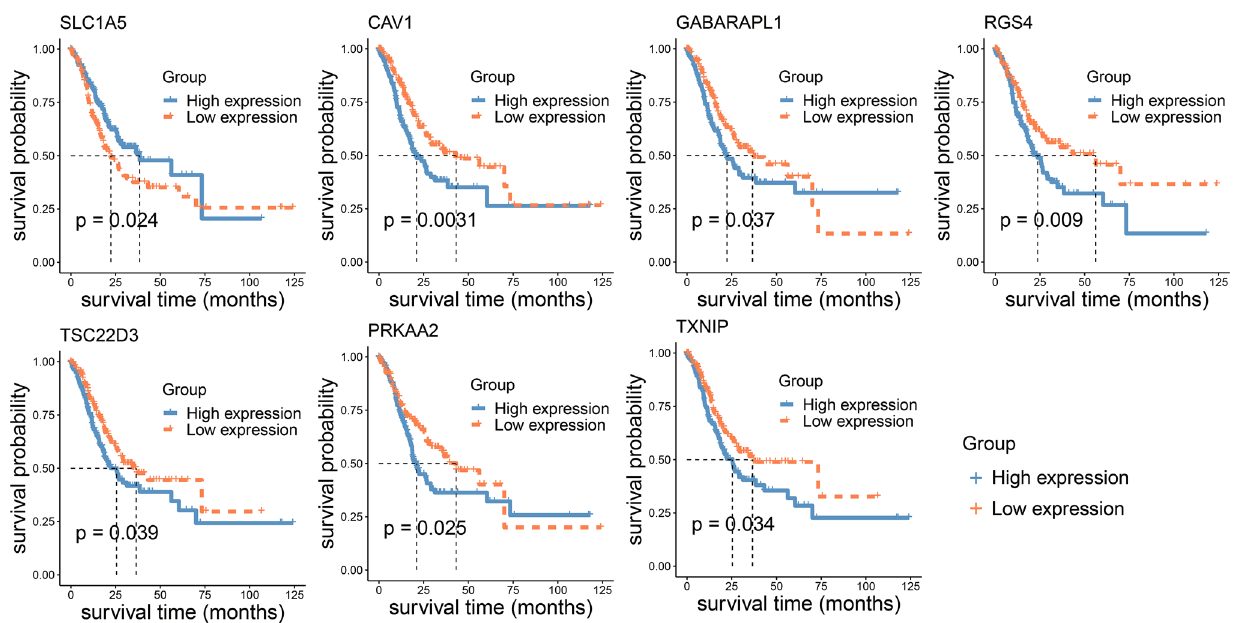
Figure 4. The Kaplan-Meier survival analysis of ferroptosis-related genes. The p value was calculated by the log-rank